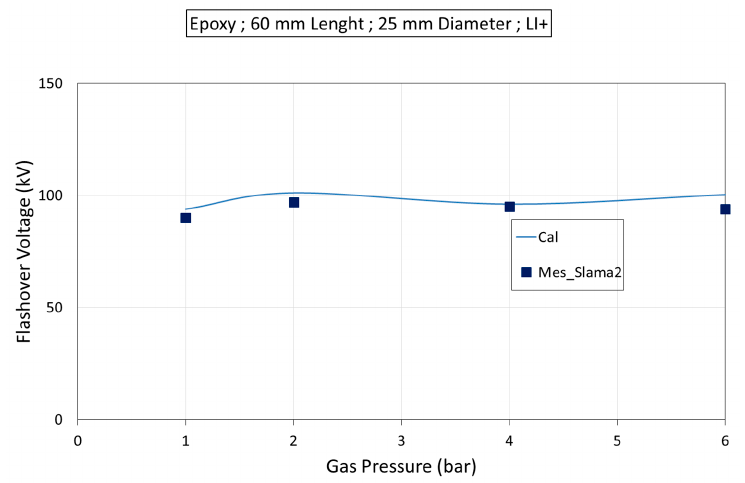
Figure 11. Comparison between calculated and measured flashover voltage versus gas pressure for insulator 2 with 60 mm length and 25 mm diameter.